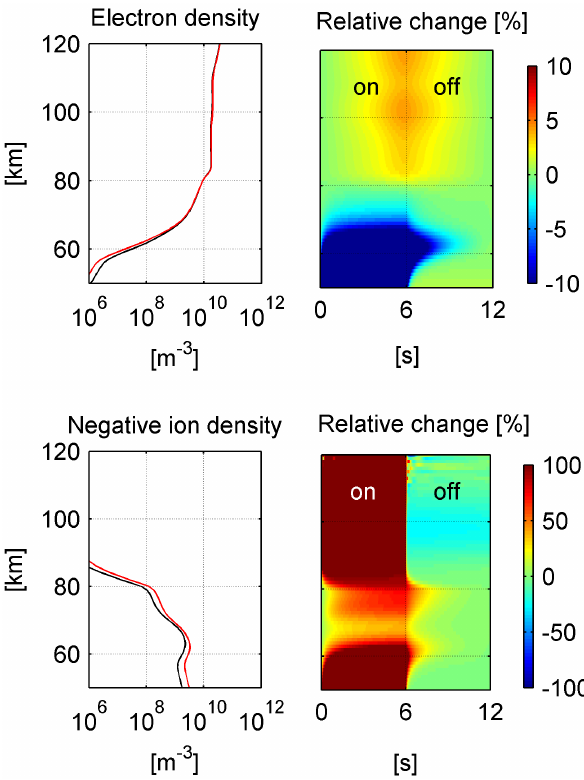
Fig. 3. Ion chemistry response to the 6-s on/off heating ( T e is 5 T n during the on- and T n during the off-period). Panels on the left side: electron and negative ion density difference between the ends of the on- and off-periods (red and black lines respectively). Panels on the right: relative change of the electron and negative ion density as a function of